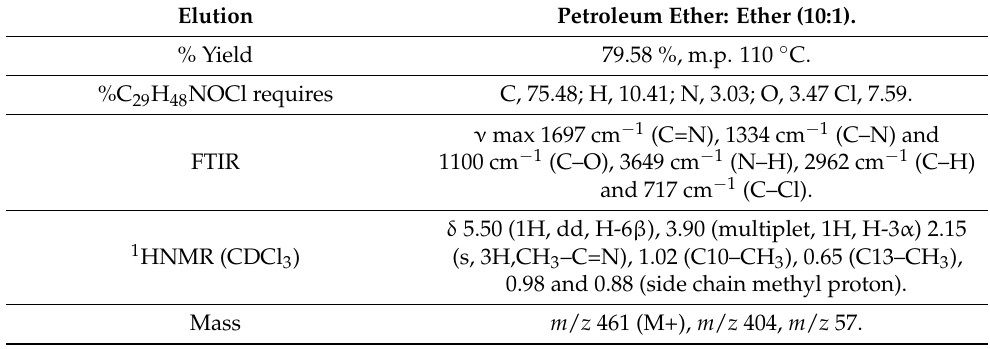
Table 1. FTIR, 1 HNMR, and mass analyses of 3 β -Chloro-5 α -cholestano-2 (cid:48) -methyl-2-oxazoline ( V